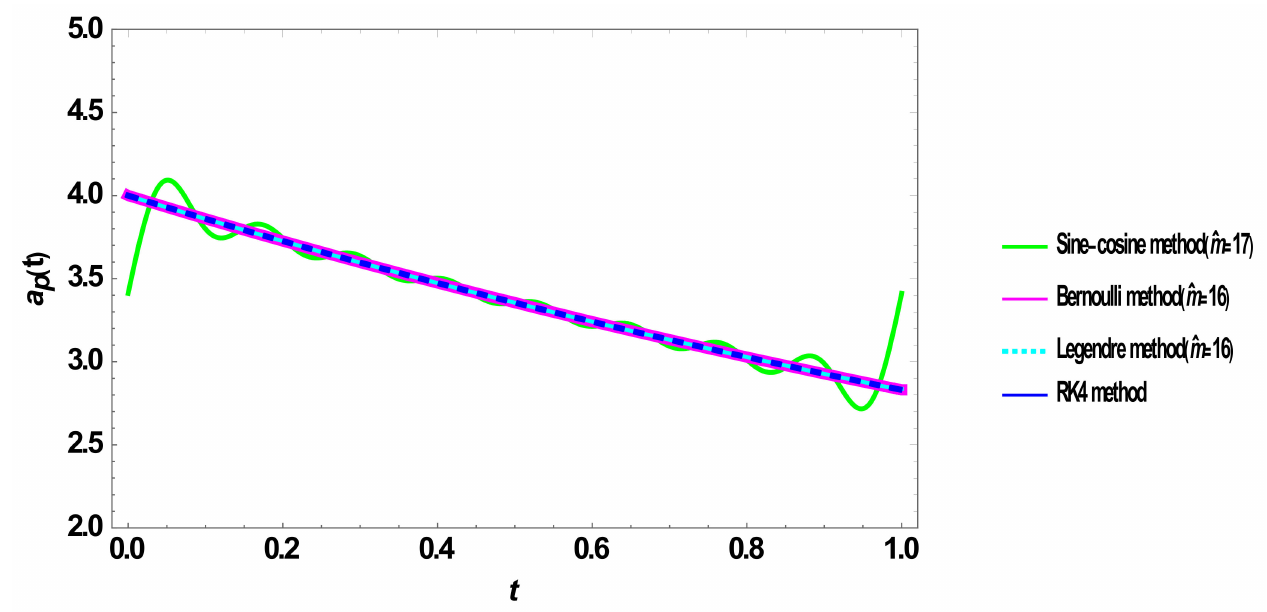
Figure 4. Comparison of the numerical solutions of a p ( t ) by using the sine–cosine wavelets method, Bernoulli wavelets method, ALPs and RK4 methods for υ = 1.